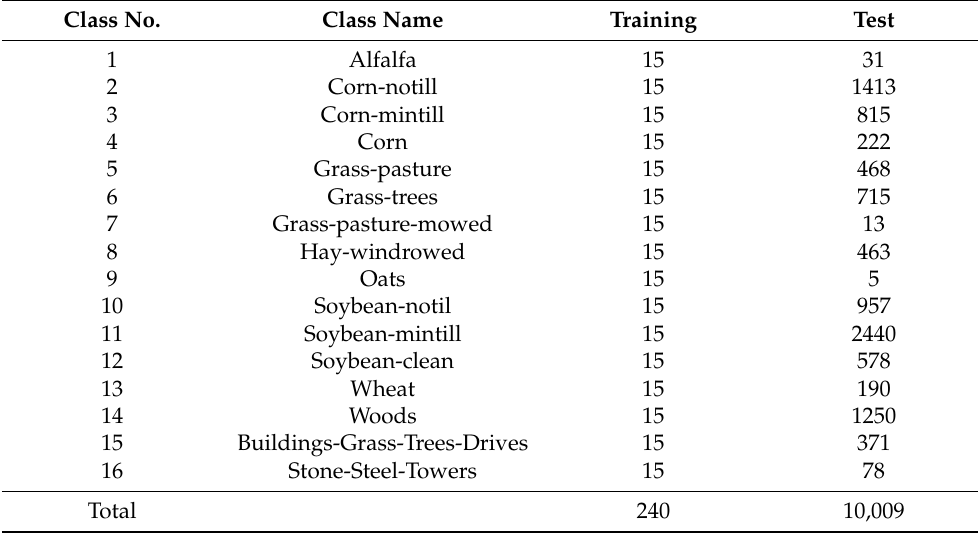
Table 4. The land cover category and data division of the Indian Pines Dataset. Class No.